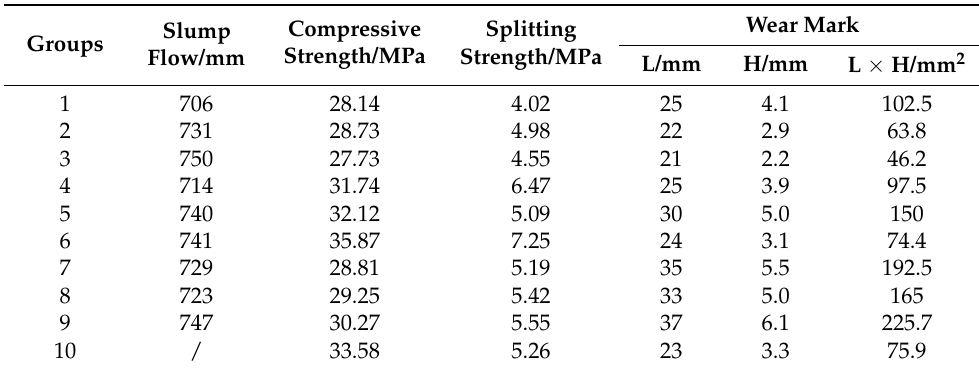
Table 8. Experimental results.